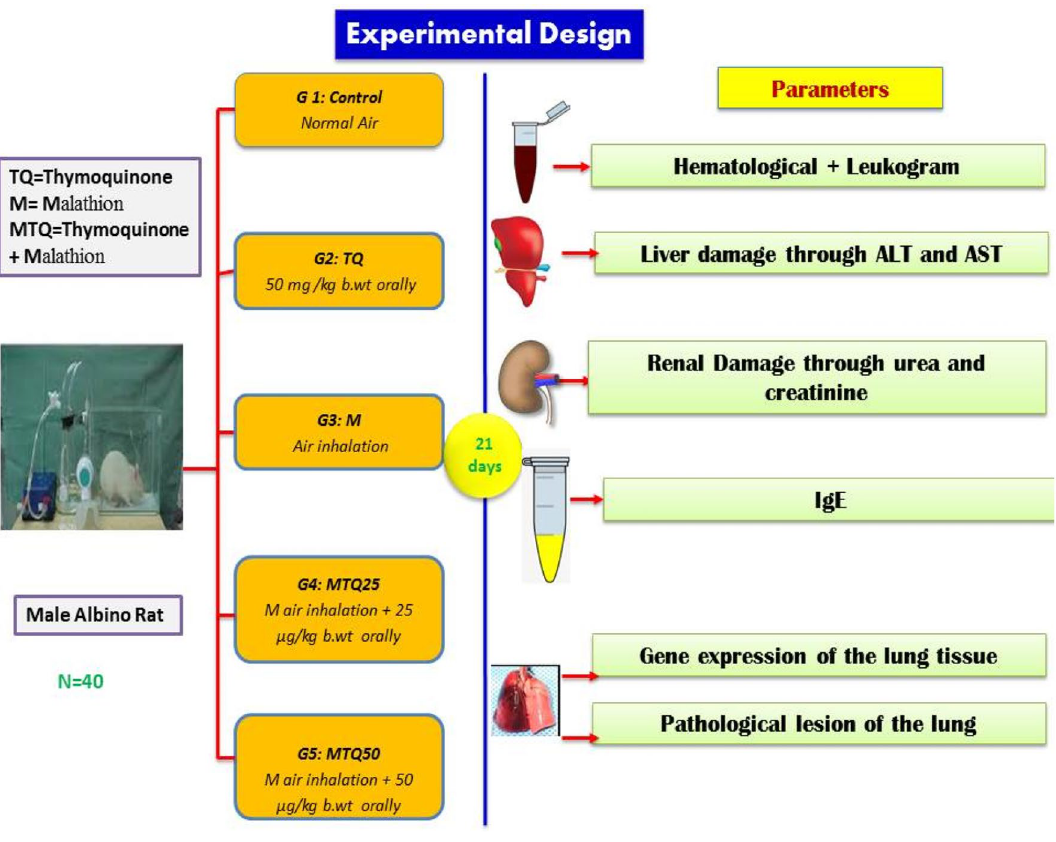
Figure 1. Protocol of the